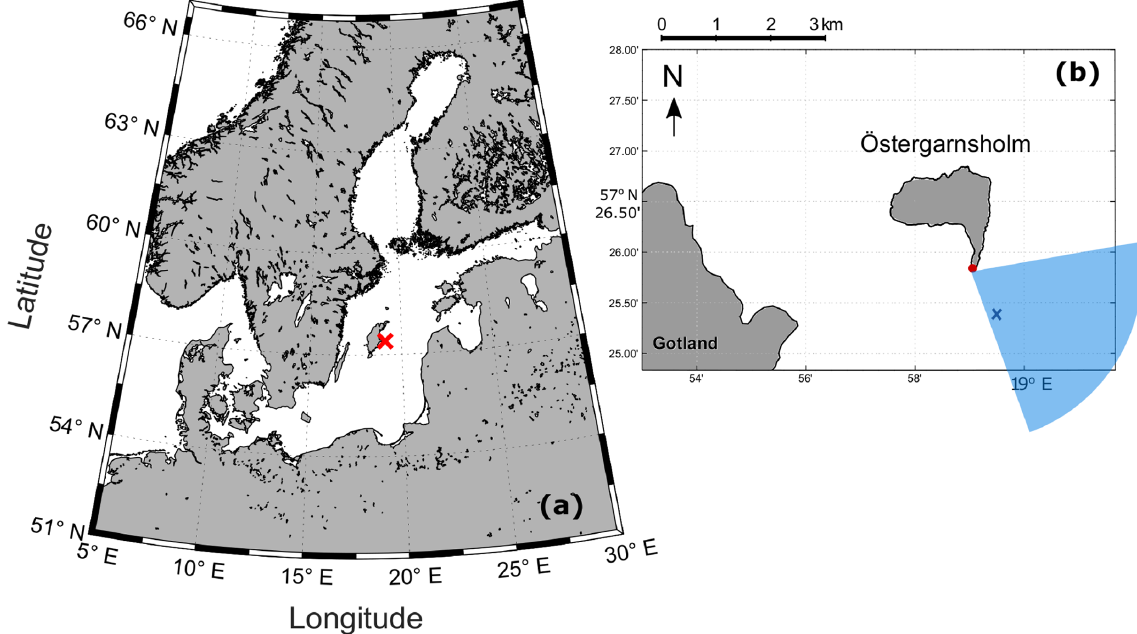
Figure 1. (a) Map of the Baltic Sea; the red cross in the central Baltic Sea indicates the location of the Östergarnsholm station. (b) Map of the Östergarnsholm station ca. 4km off the Gotland Island; the red dot indicates the location of the tower; the blue cross is the location of the mooring with water-side instrumentation (Sect. 2.1.2); the shaded blue area is the so-called “open-sea” sector with wind directions from 80 ◦ < WD < 160 ◦ (see Sect. 2.1.1 for details).